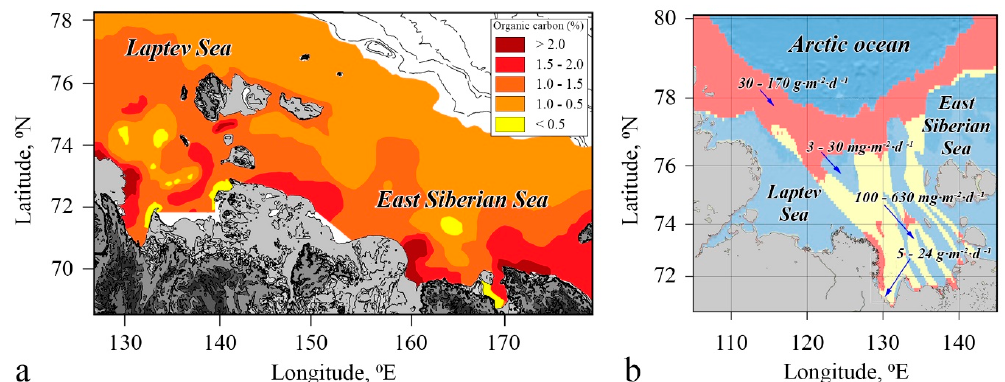
Figure 7. Distribution of total organic carbon (C org ) in the surface sediments vs. current state of subsea permafrost and CH 4 fluxes from the sea floor/sea surface in the ESAS. ( a ) The percentage of C org in the surface sediments over the East Siberian Arctic Shelf (ESAS); ( b ) rates of CH 4 fluxes observed in the ESAS vs. results of permafrost modeling. Areas marked in coral represent areas where subsea permafrost is predicted to be exhibiting the most advanced stages of degradation due to duration of inundation; areas marked in yellow represent areas of modeled taliks developing due to geological factors (faults) and the warming effect of river discharge; areas marked in blue represent the areas where subsea permafrost presumably remains the least disintegrated. Grey color shows the land modified from [21].